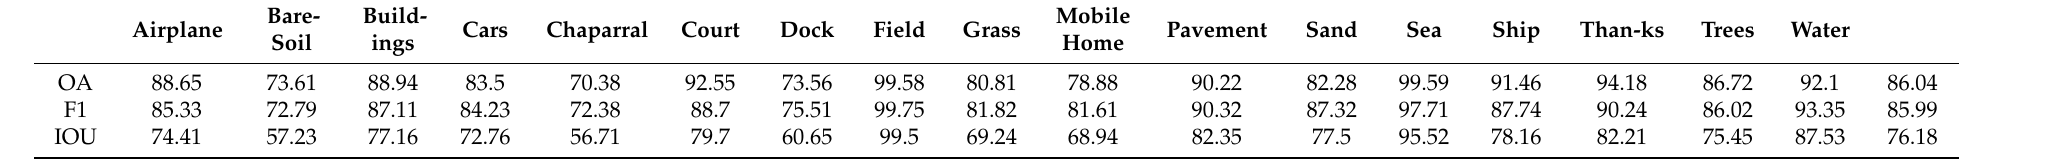
Table 6. The results of RE-Net on DLRSD.